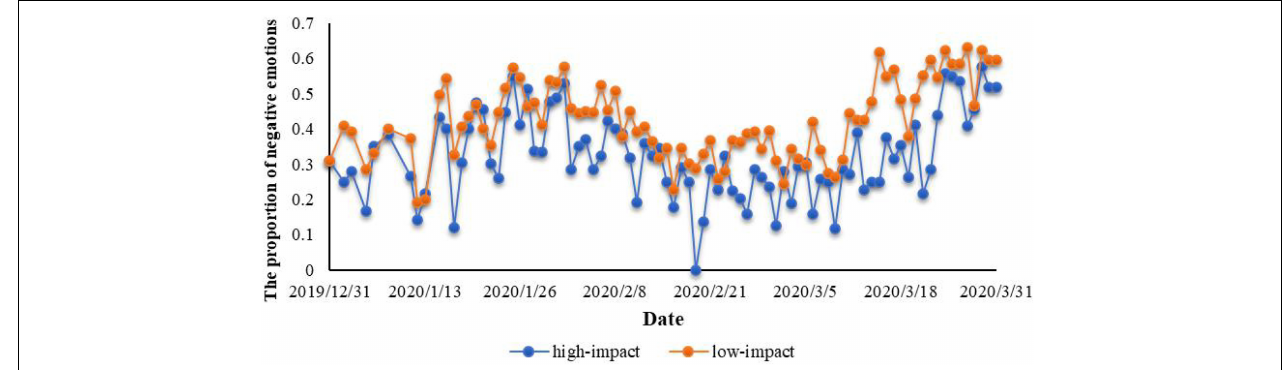
FIGURE 8 | Difference in the proportion of negative emotions between high-impact and low-impact groups.